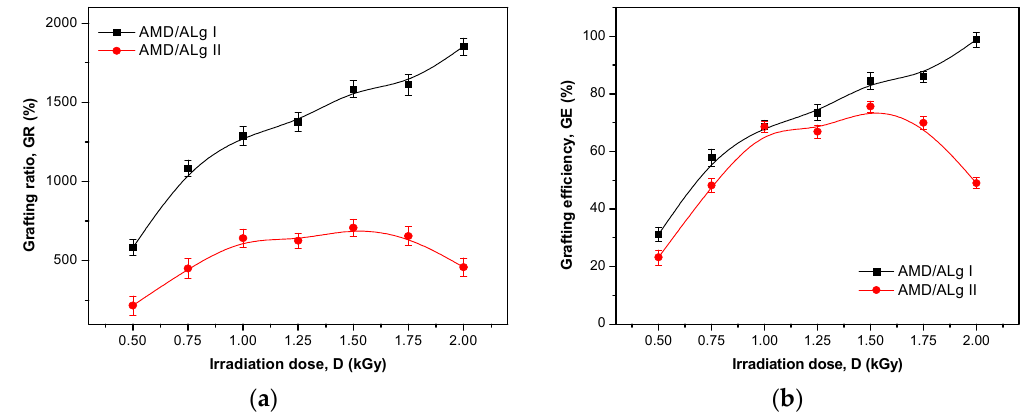
Figure 2. Grafting ratio ( a ) and grafting efficiency ( b ) as a function of sodium alginate concentration and irradiation dose.